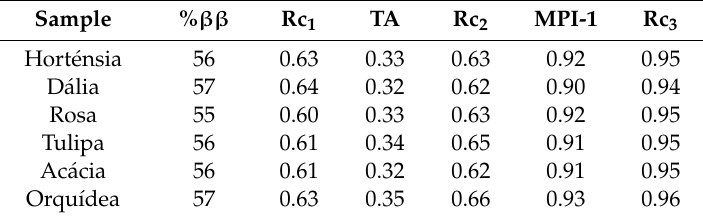
Table 3. Some maturity-related molecular parameters for saturated and aromatic fractions in the oil